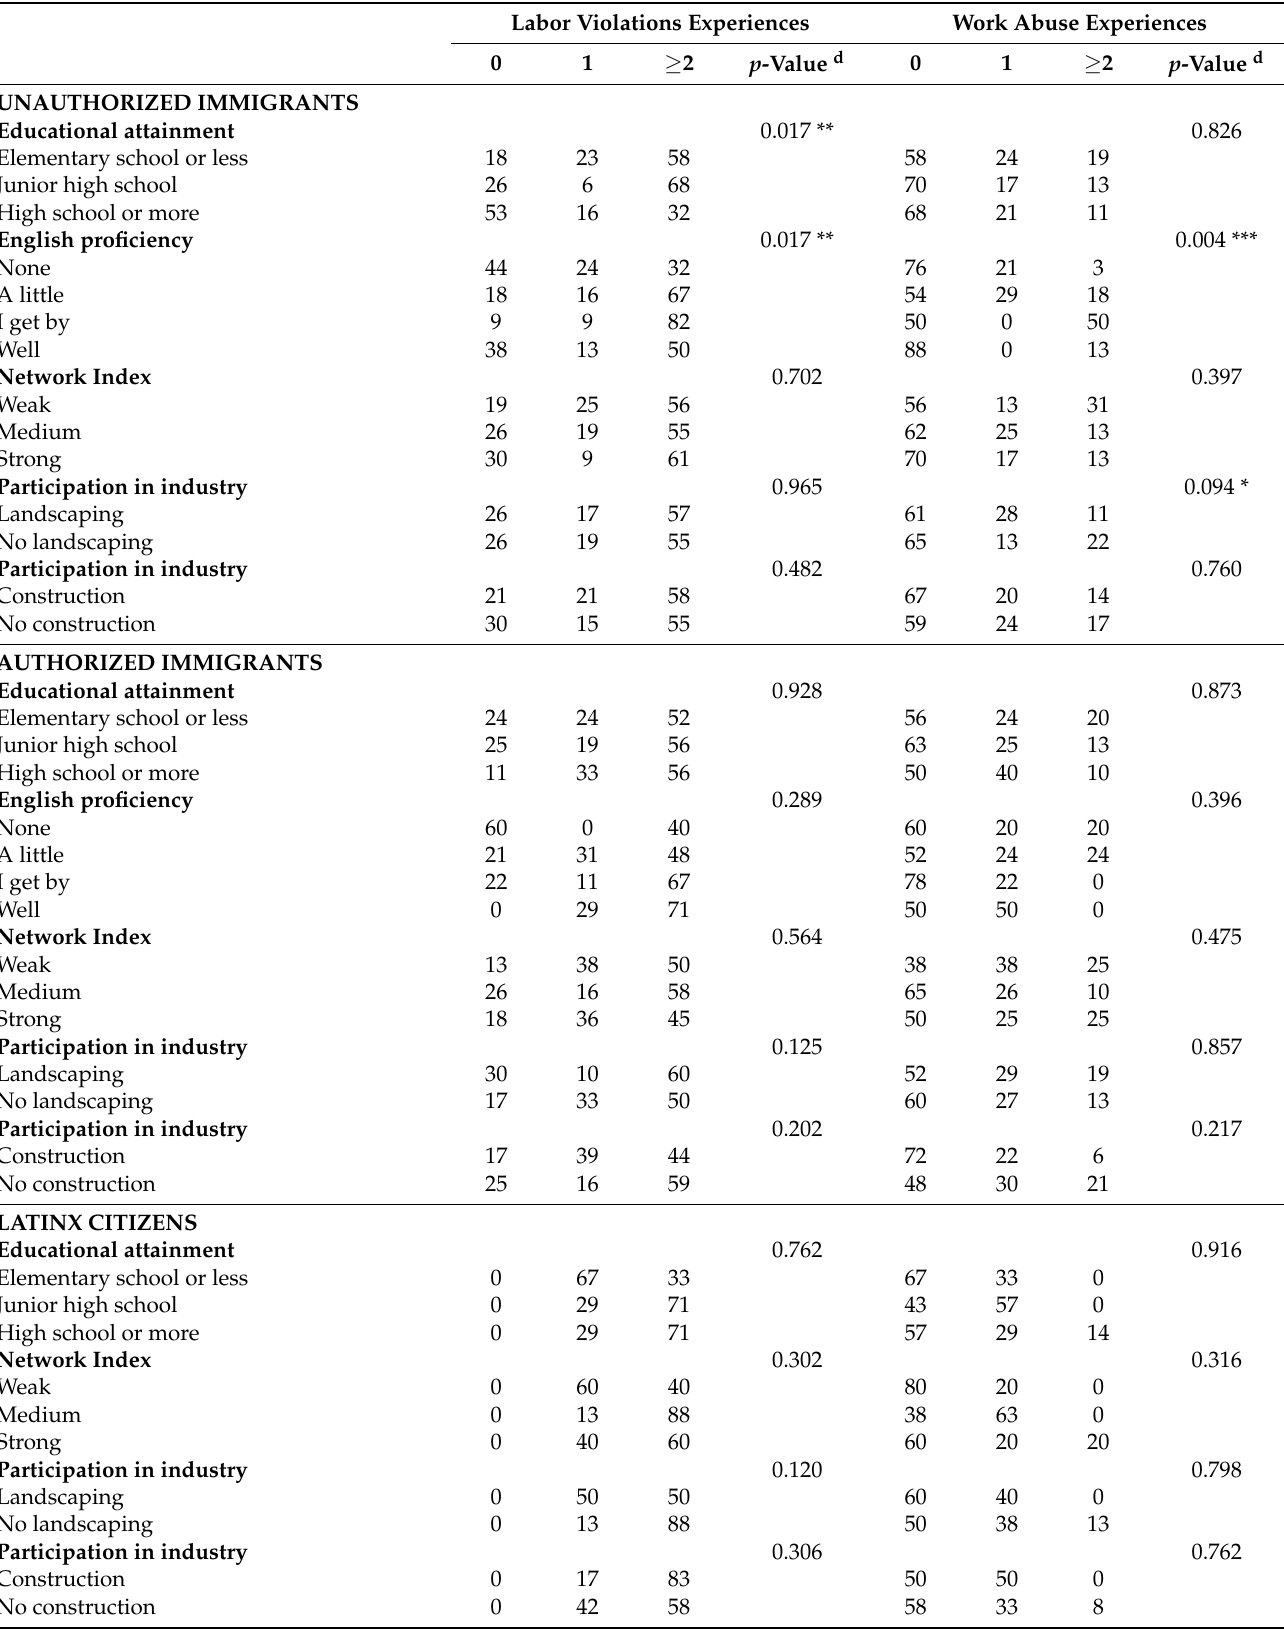
Table 5. Tests of independence between the incidence of labor violation or work abuse and variables of interest a–c